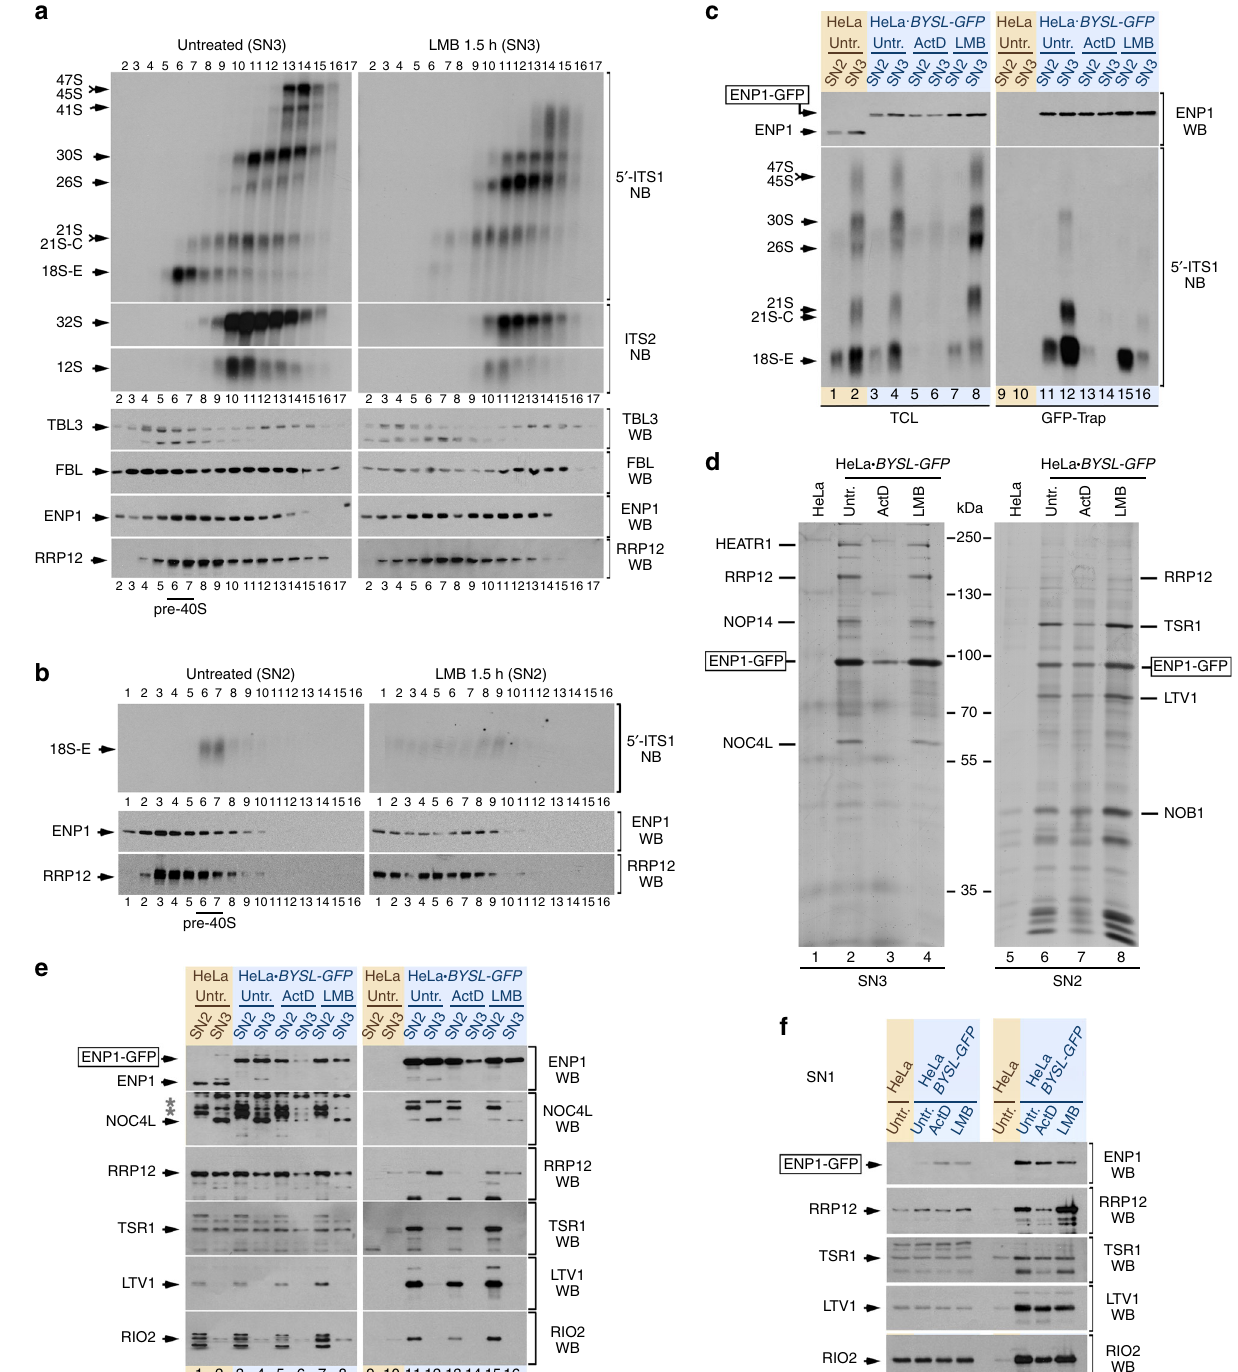
factor that was not detected as a main interacting protein of ENP1-GFP in silver-stained gels (Fig. 2d), does interact with ENP1 in a minor pool of complexes speci fi cally present in the SN2 supernatant of the PSE method (Fig. 2e). We could not assess the possible presence of PNO1, another known late- maturation RBF, in the ENP1-GFP-containing complexes using Western blot analyses due to the lack of good antibodies for this protein. As expected for interactions taking place within pre- ribosomal complexes, we found that the associations of the RBFs NATURE COMMUNICATIONS| (2020) 11:156